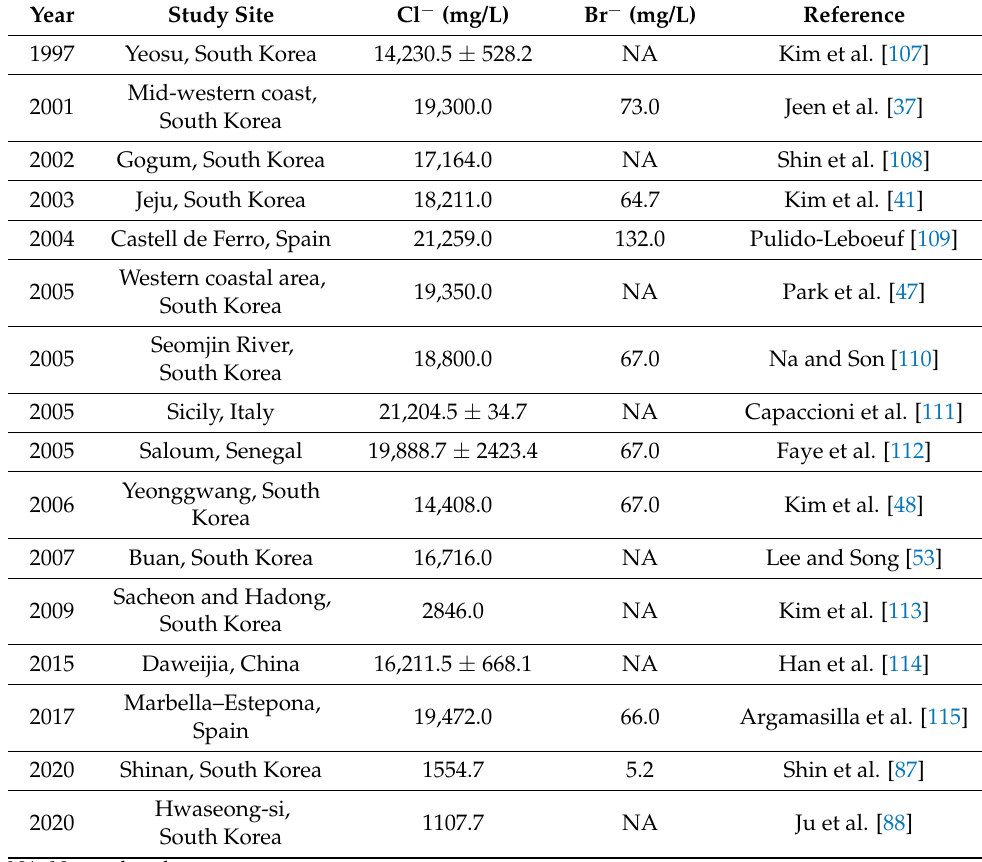
Table 2. Chloride and bromide concentrations of seawater or brackish water reported in previous studies.